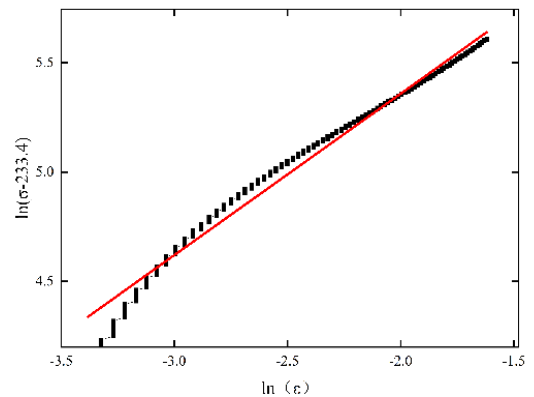
Figure 5. Linear fitting of parameters A, B and N